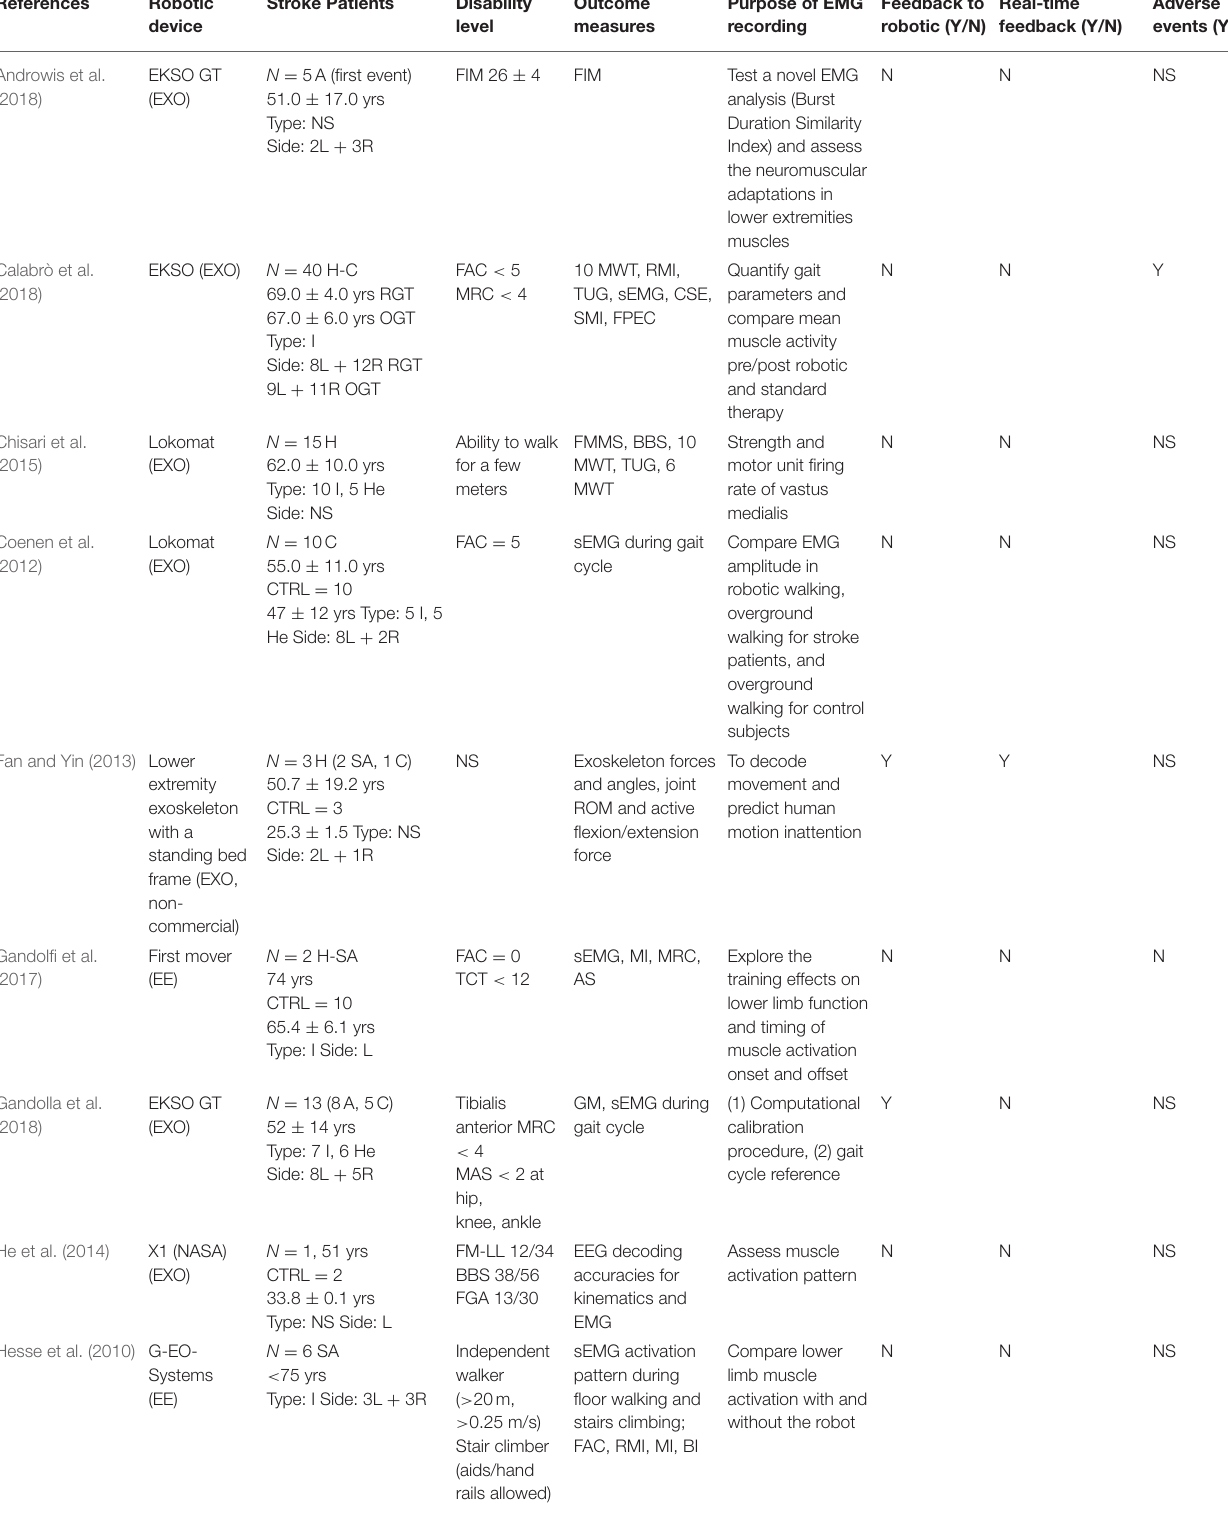
TABLE 2 | Electromyography (EMG)-based robotic studies (participants and